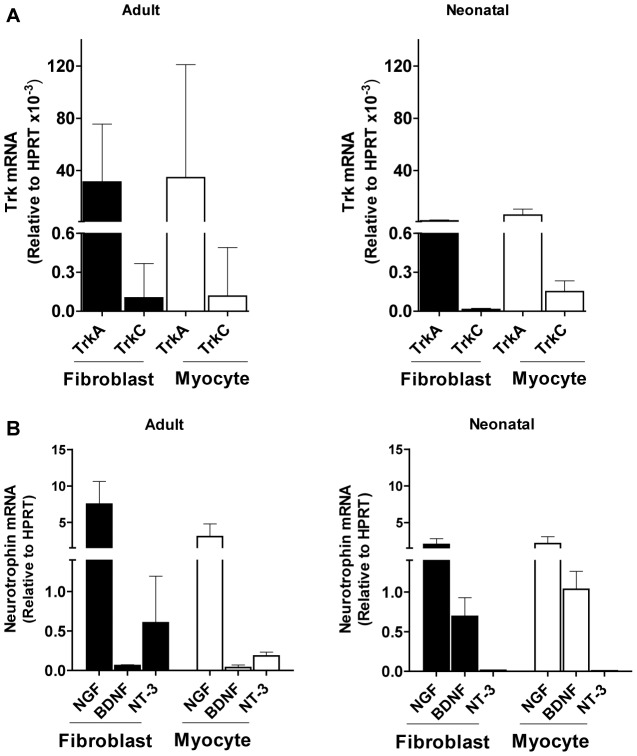
Expression of neurotrophin receptor and ligands in primary cultures of cardiac fibroblasts and myocytes.
A) Primary cultures of cardiac fibroblasts express TrkA mRNA at levels higher than TrkC mRNA, comparable to the expression in cardiomyocytes. Cardiac fibroblasts and cardiomyocytes were isolated from adult female (left) or neonatal (right) C57BL/6 mice and their Trk transcripts quantified by qPCR. Data are combined from at least three separate experiments, each point in triplicate. B) Variable expression of neurotrophin mRNAs in primary cultures of adult or neonatal cardiac fibroblasts and myocytes. NGF, BDNF and NT-3 mRNAs were assessed by qPCR in primary cultures of adult female (left) or neonatal (right) cardiac fibroblasts (CF) and myocytes. Two technical replicates each on triplicate samples were normalized to HPRT and graphed as mean + s.d.